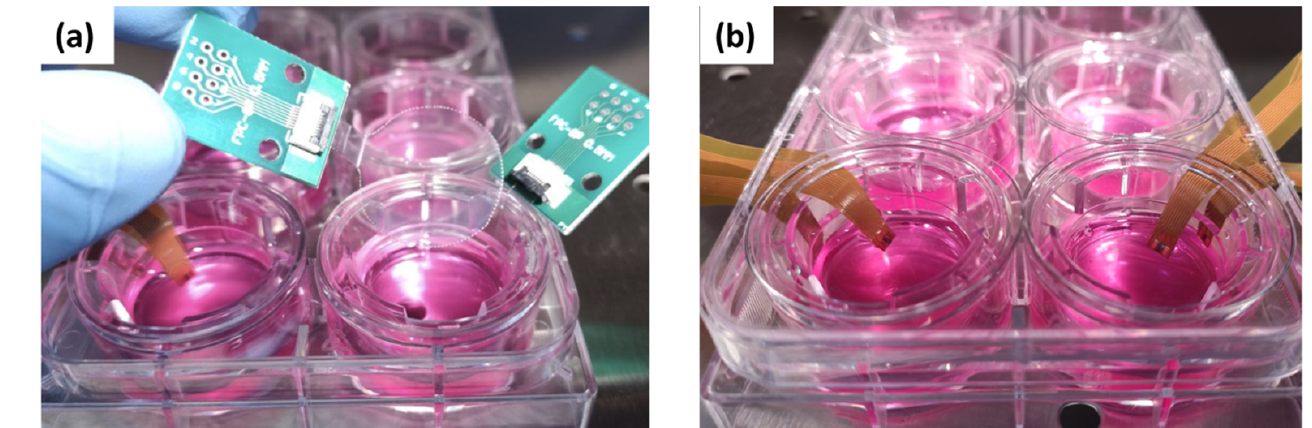
Figure 2. Photographs of sensor-integrated Transwell™ plates. TEER measurement set-up by circular transparent electrodes with FPC-to-DIP adapters ( a ). Ion-selective flexible sensors inserted in transwell plate, one for each compartment (top and bottom) of the well; each sensor can measure two different ions with a common thin film Ag/AgCl reference electrode (black electrode on flex between the two working electrodes) ( b ).